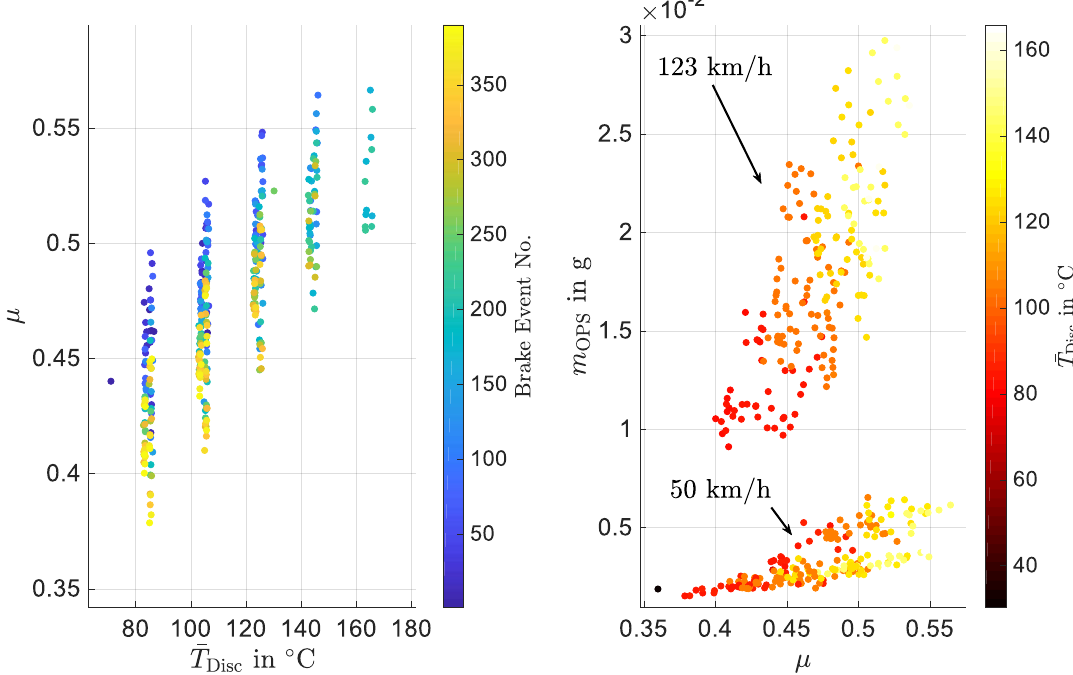
Figure 12. Correlation of PM 10 emission per brake event calculated by the OPS size distribution and a density of 3.5 g/cm³, average disc temperature T per brake event, and the coefficient of friction µ for the pad material with an organic binder during the multiple triangle test below the critical temperature.